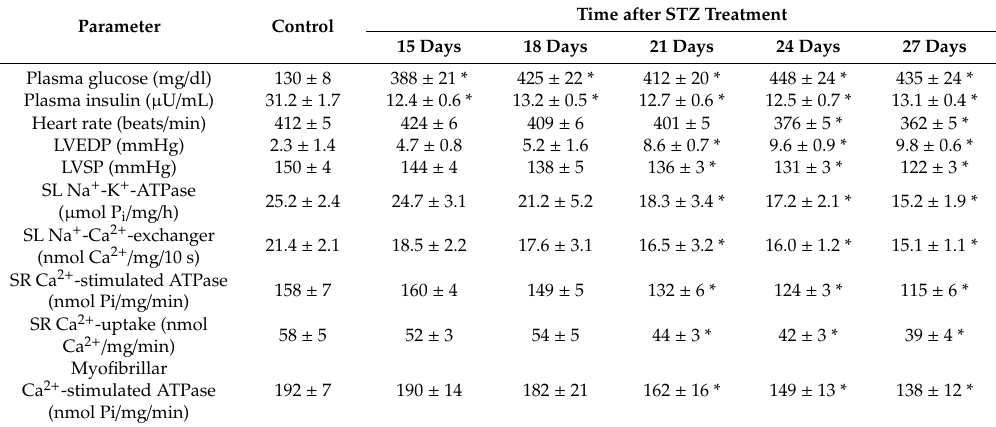
Table 2. Time-course of changes in hemodynamic parameters, plasma glucose and insulin profile of control and diabetic animals at di ff erent time points following streptozotocin (STZ) injection. Parameter